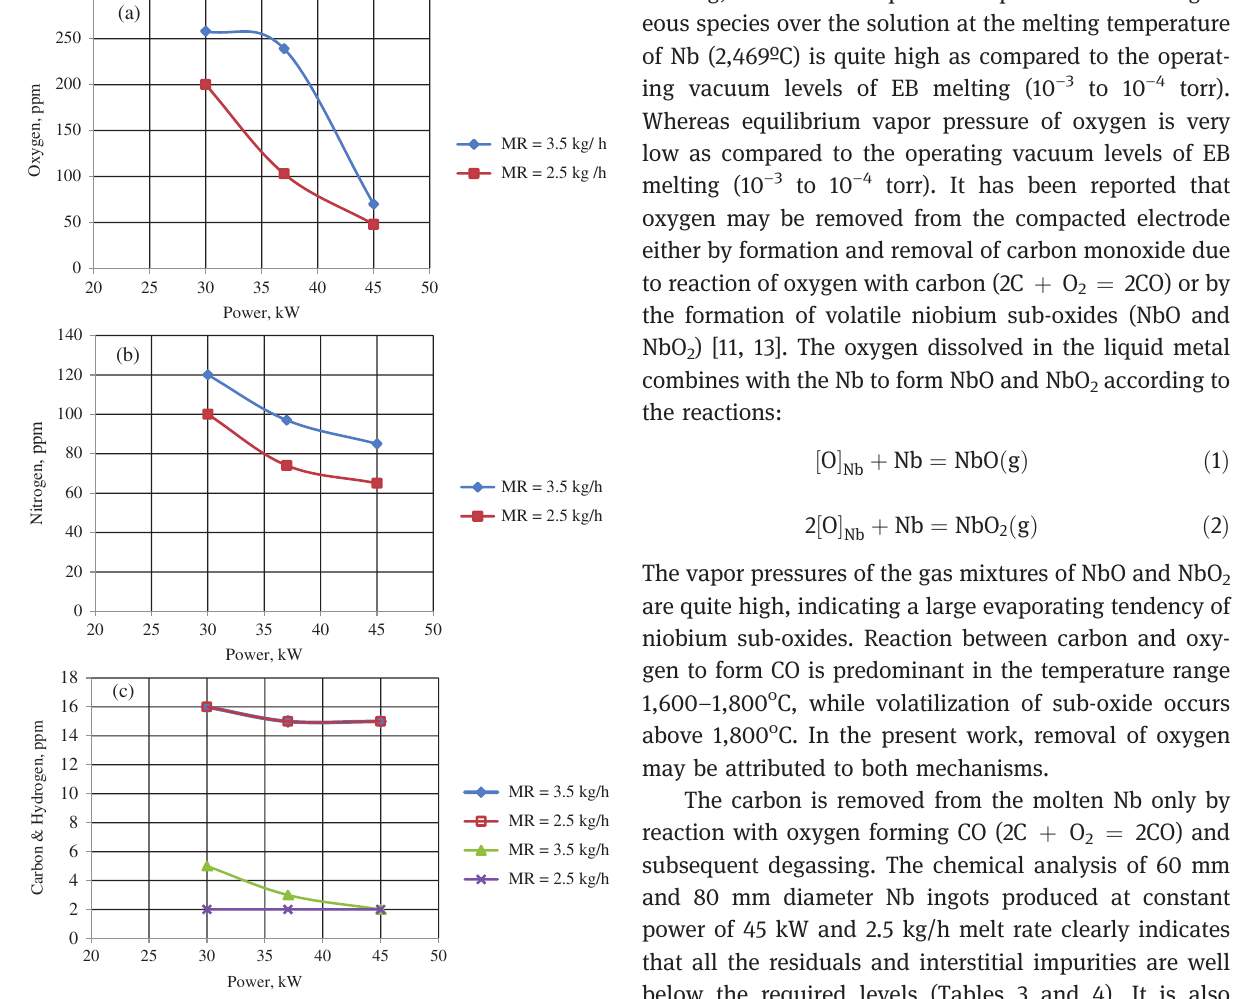
Figure 3: Effect of input power and melt rate on concentration of (a) oxygen, (b) nitrogen and (c) carbon and hydrogen in 60 mm diameter EB melted ingot (MR ¼ melt rate).